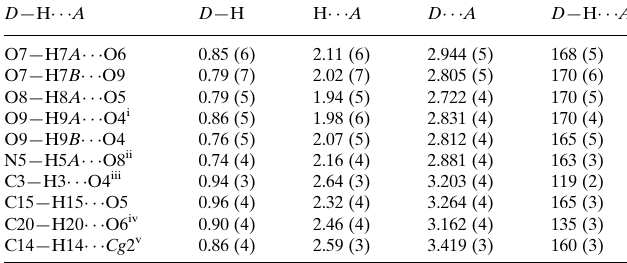
Hydrogen-bond geometry (A˚ , (cid:3) ). Cg 2 is the centroid of the N2/C7–C11